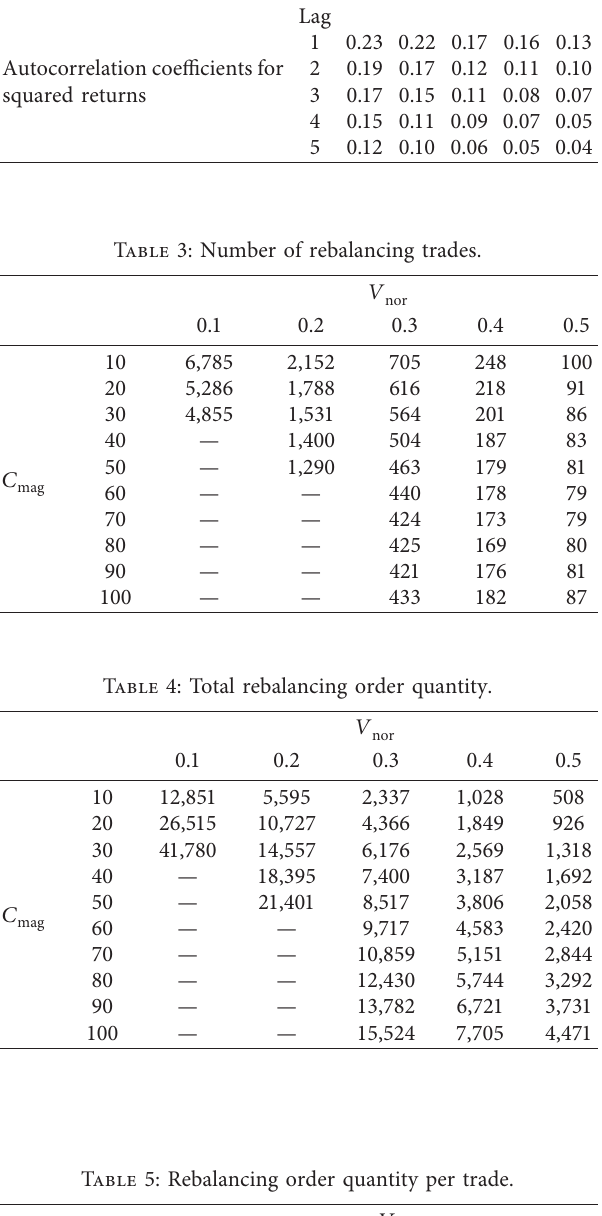
Table 2: Stylized facts. C